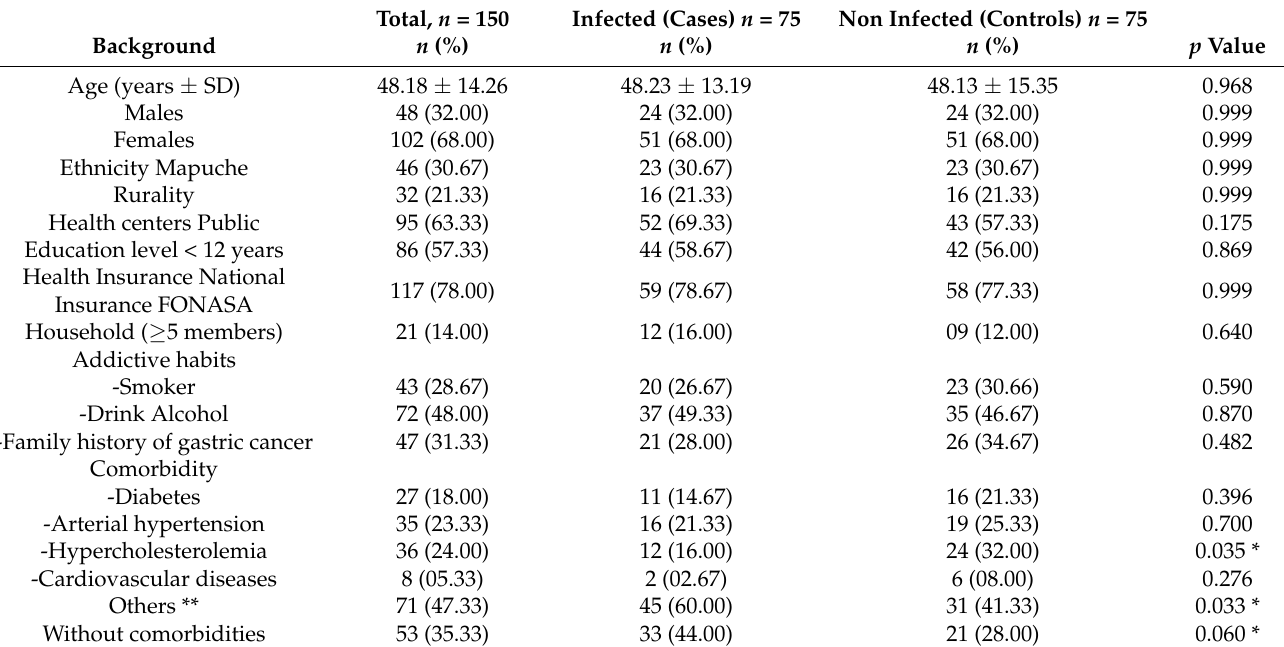
Table 1. Sociodemographic characteristics of the participants infected and non-infected with H. pylori ( n = 150).